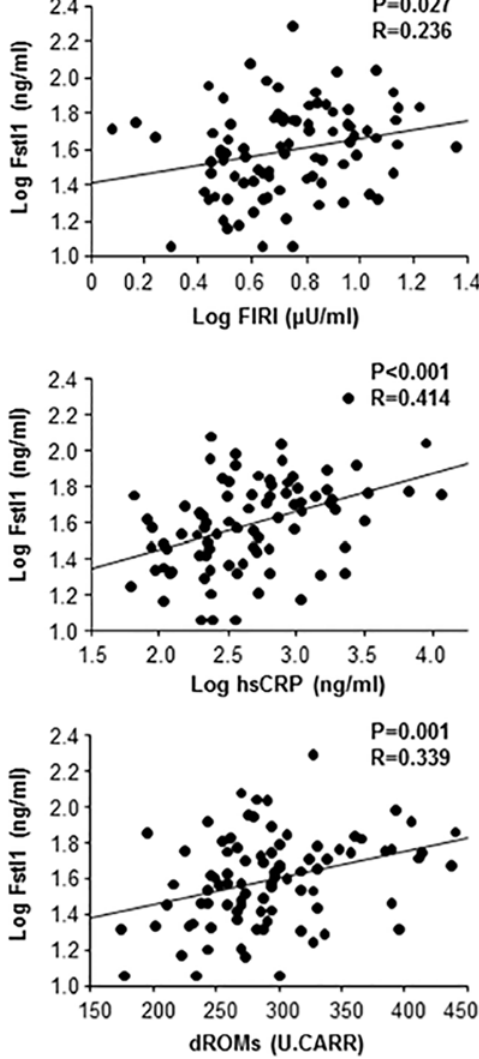
Fig 1. Correlation between plasma Fstl1 levels and clinical parameters. Correlation of plasma Log Fstl1 levels with Log fasting immune-reactive insulin (FIRI), Log high sensitive CRP (hsCRP) and derivatives of reactive oxidative metabolites (dROMs) was